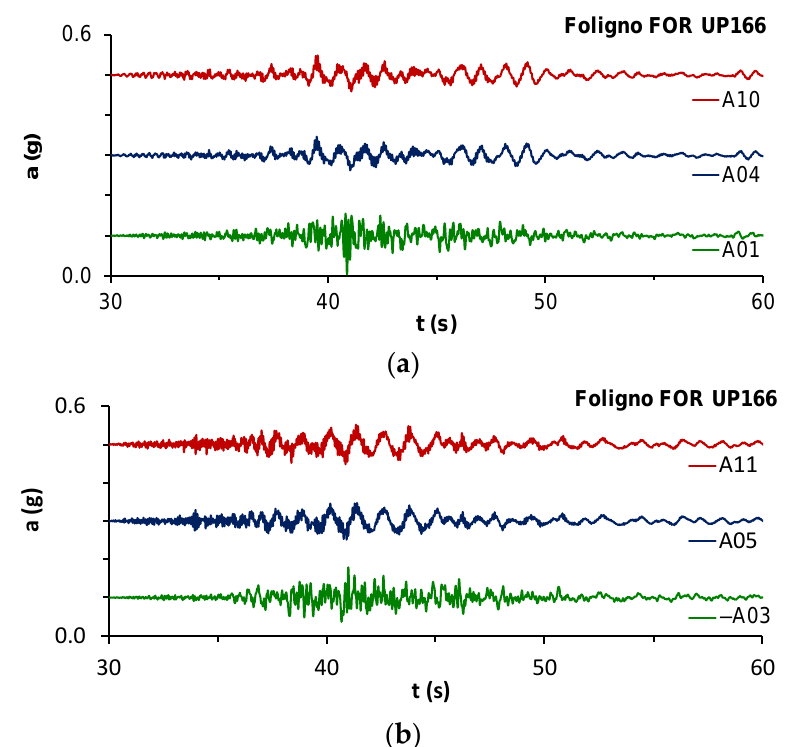
Figure 5. Time histories at the basement (green), at the first floor above the isolation system (blue) and at the top of the building (red) during the 30 October 2016, Norcia earthquake in ( a ) x direction and ( b ) y direction (the sign of record at A03 has been changed; therefore, it is named –A03 in the legend). The Fourier spectra for the horizontal sensors are plotted in Figure 6. The sensors in the same direction, deployed in the superstructure, show a peak of amplitude for the same frequency, equal to 0.95 Hz in x direction and 0.81 Hz in y direction. These resonance frequencies are much lower than the resonance frequencies recorded under ambient vibrations and related to the superstructure. The spectrum rotates of the recordings obtained at the couples A04–A05 and A10–A11 confirmed the presence of two different frequencies along the two main directions (Figure 7).